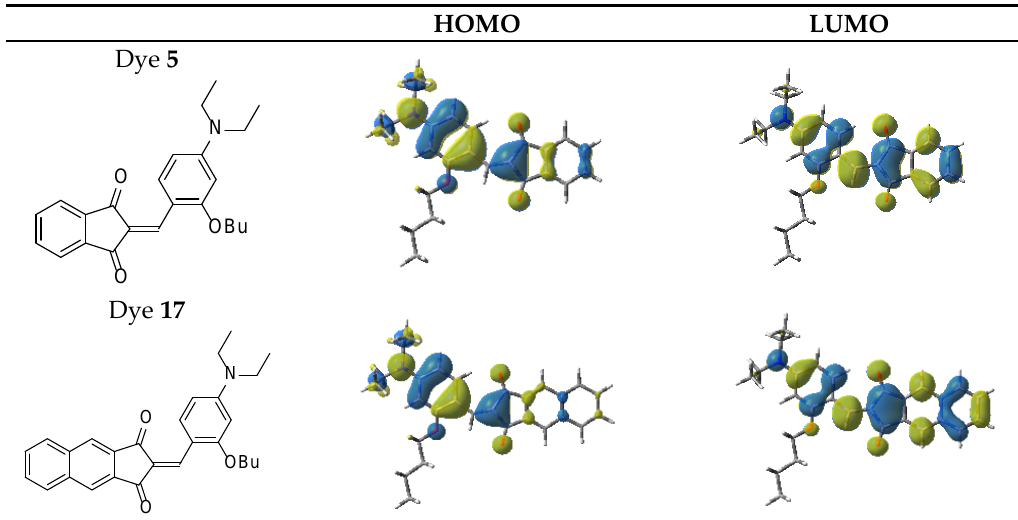
Figure 2. Contour plots of HOMOs and LUMOs for dye 5 and dye 17 (isovalue = 0.02).